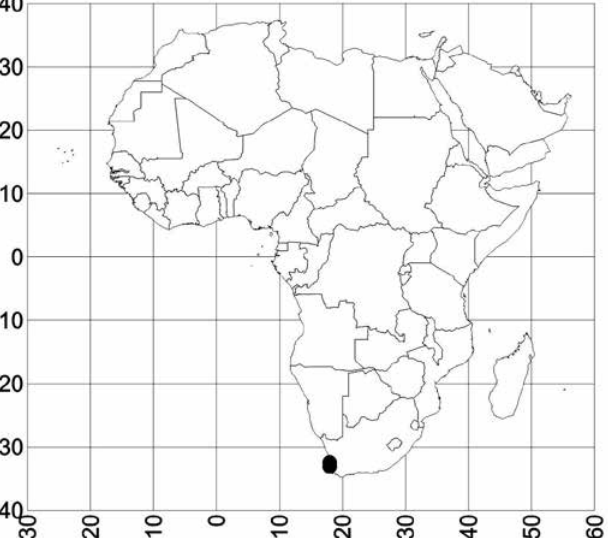
Map 7 . The distribution of B. laevissima